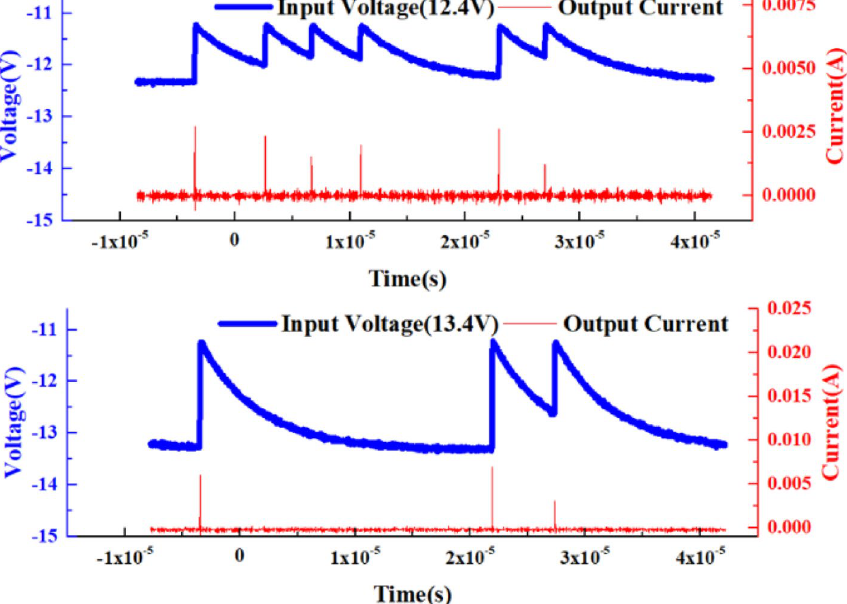
Figure 11. Test voltage–time curve and test current–time curve (12.4 V, 13.4 V) of VADTS under the excitation of random continuous pulse signals with short